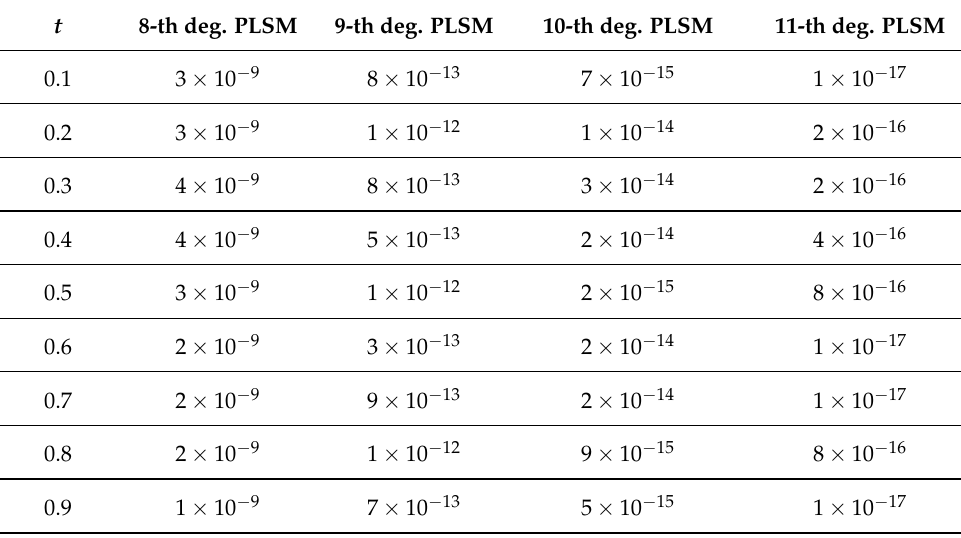
Table 3. Comparison of PLSM absolute errors of x 1 for problem (17) in the case α 1 = α 2 =